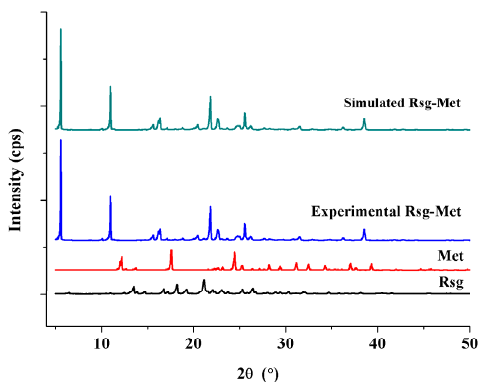
Figure 2. X-ray powder diffractograms of Rsg-Met, Met and Rsg.